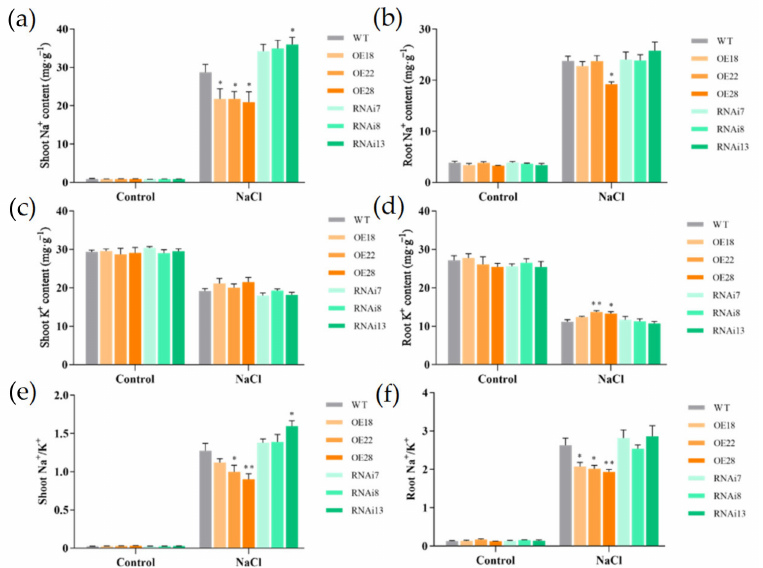
Figure 2. Effects of NaCl treatment on the ion content of wild-type (WT), overexpression (OE18, OE22, and OE28), and RNAi lines (RNAi7, RNAi8, and RNAi13). ( a ) Shoot Na + content, ( b ) root Na + content, ( c ) shoot K + content, ( d ) root K + content, ( e ) shoot Na + to K + ratio, and ( f ) root Na + to K + ratio were sampled from control or 6 d salt-treated rice seedlings. The experiment was repeated three times, and each treatment included four replications. Data are means ± SE ( n = 4). An asterisk indicates a significant difference (LSD test, * p < 0.05 and ** p < 0.01) between wild-type, overexpression and RNAi